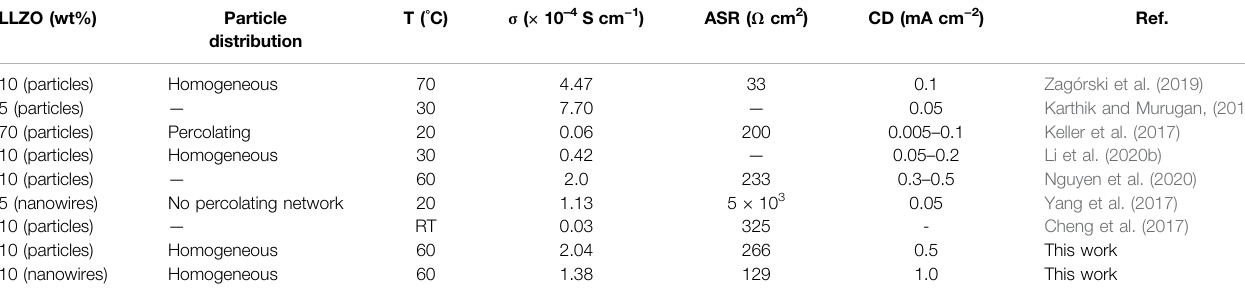
TABLE 2 | Critical current densities in comparison with values reported in the